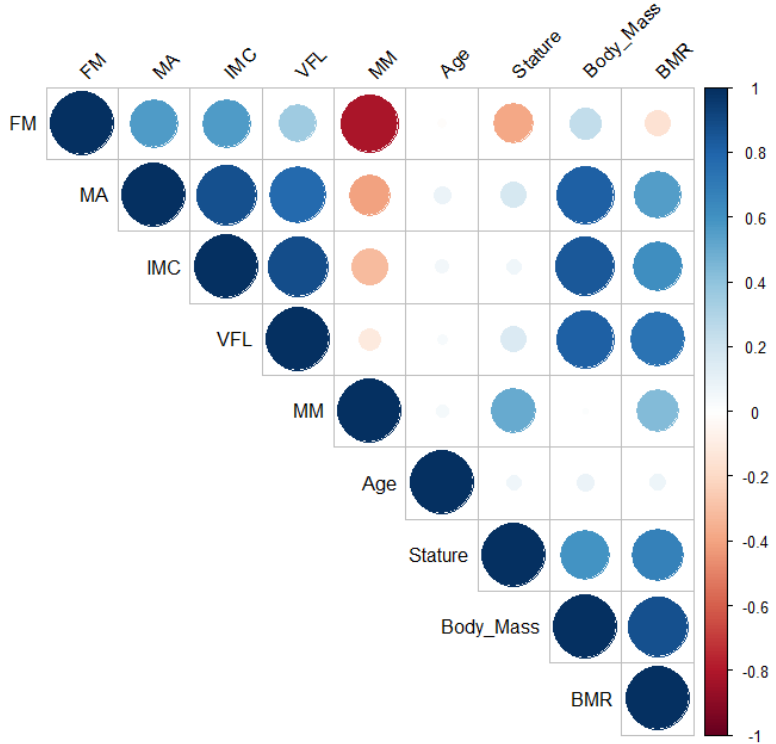
Figure 1. Draftsman correlation plot. Positive correlations are displayed in blue and negative correlations in red color. Color intensity and the size of the circle are proportional to the correlation coefficients.